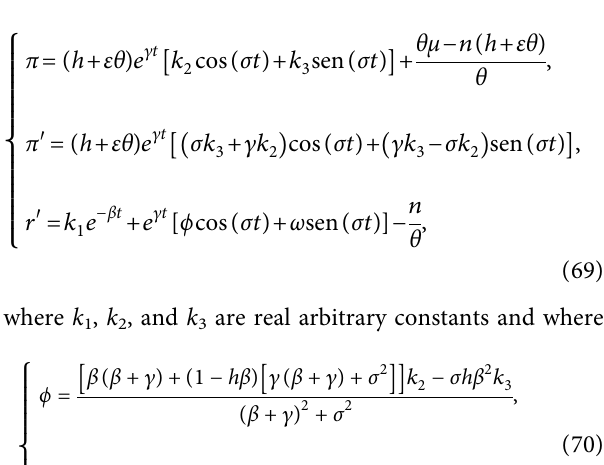
Figure 5: Projections in R 2 of the three-dimensional phase